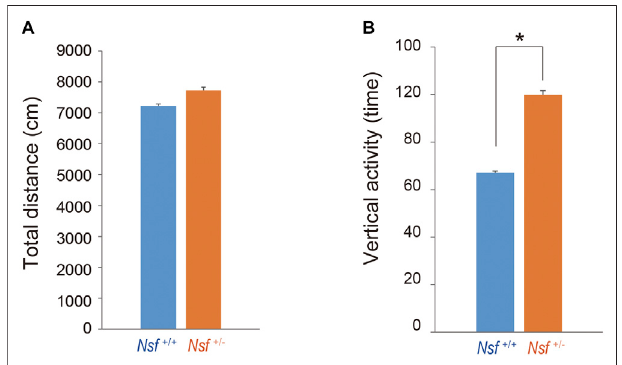
FIGURE 3 | Increase in repetitive behavior of Nsf +/ − mice in the open fi eld. (A) Total distance (locomotor activity) and (B) vertical activity (repetitive behavior) of Nsf +/+ and Nsf +/ − mice. ( Nsf +/ − mice, n (cid:1) 13, Nsf +/+ mice, n (cid:1) 11, mean ± SEM. Student ’ s t-test.* p <